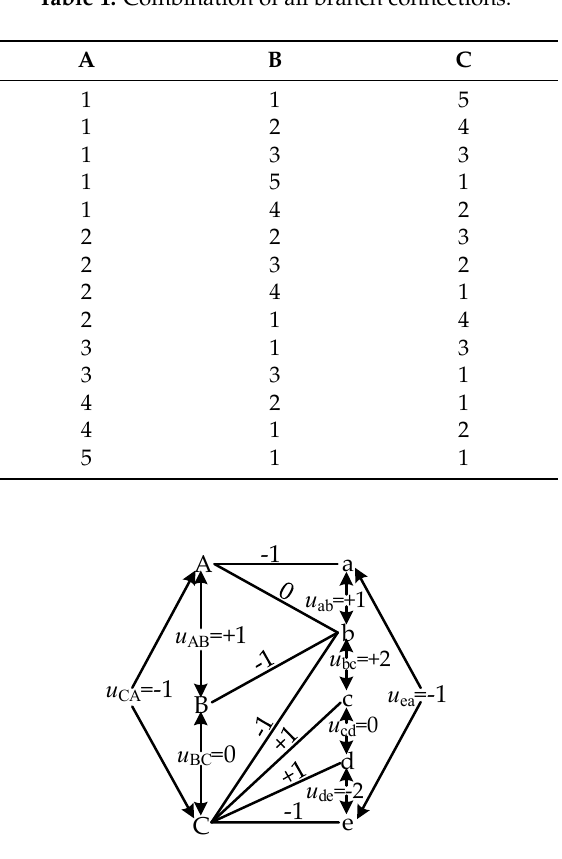
Figure 2. Vector combination of V i1 –V o2 .